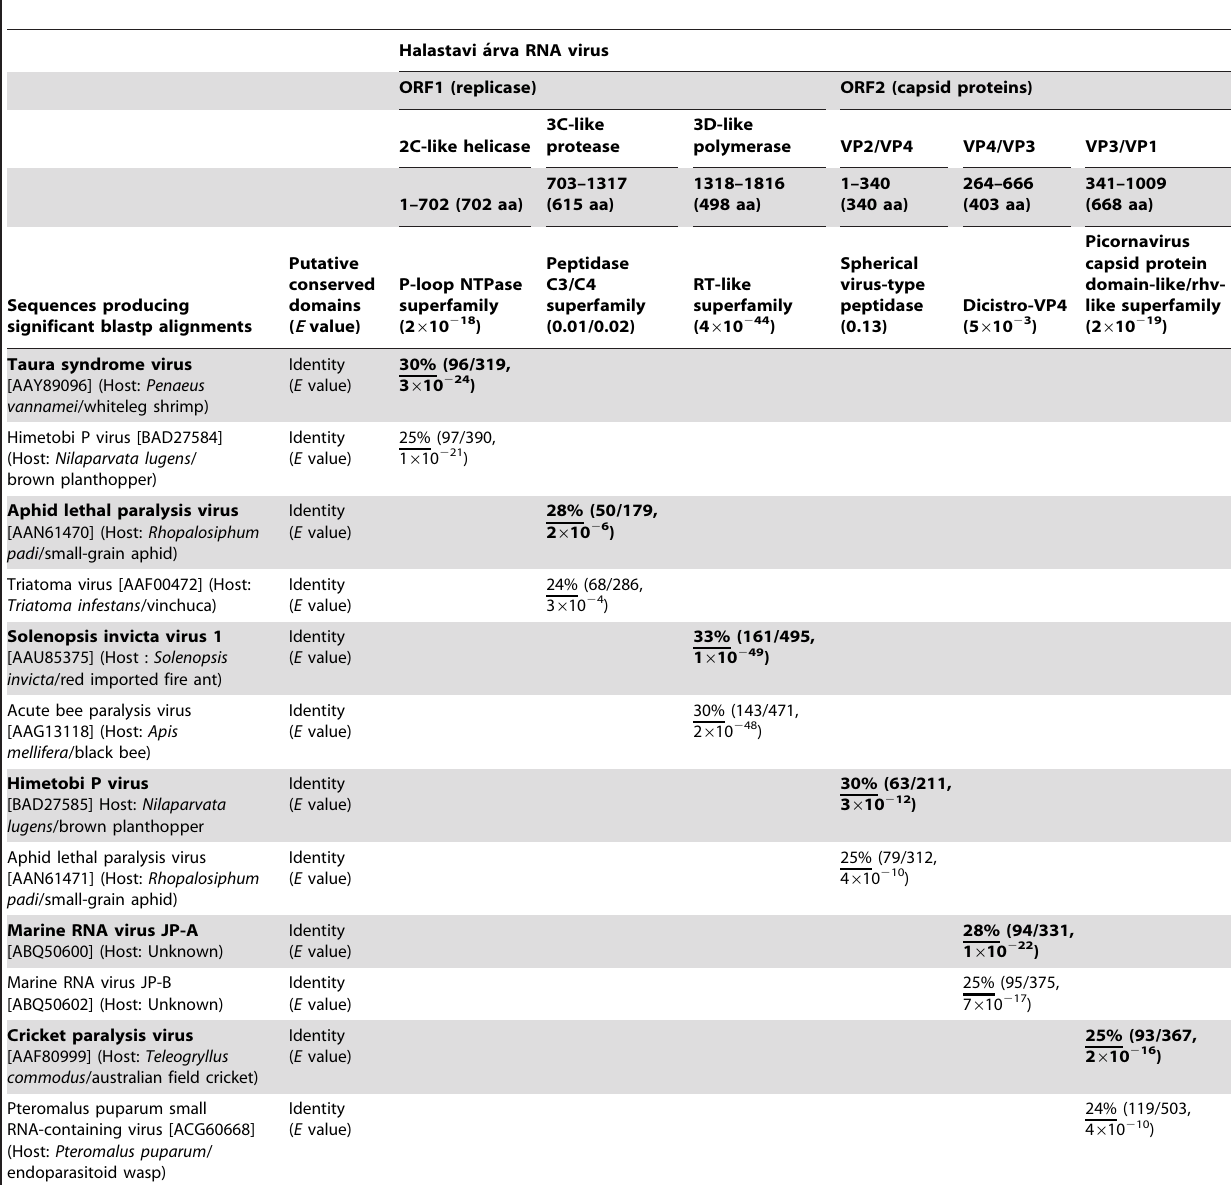
Table 2. Percental amino acid identity of the Halastavi a´rva RNA virus protein regions compared to the GenBank sequences using blastp (see details in